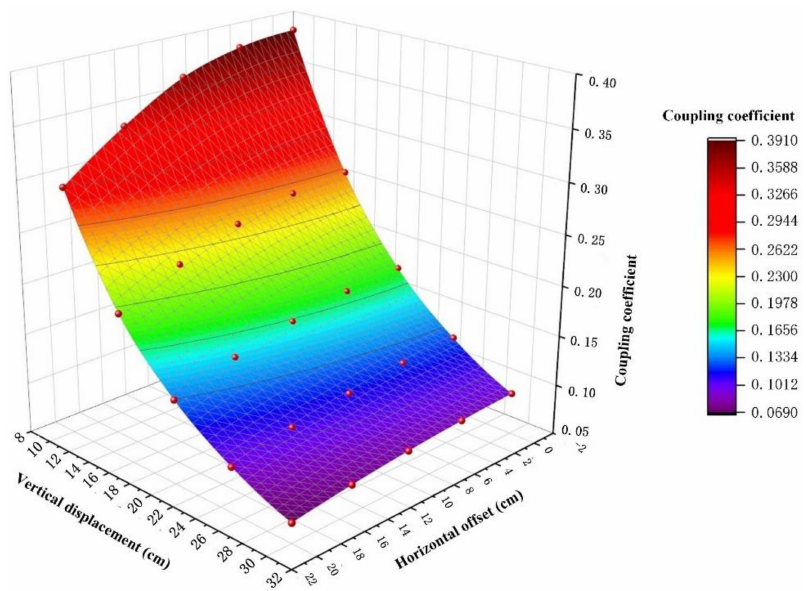
Figure 23. Relationship among the coupling coefficient and vertical and horizontal misalignment.